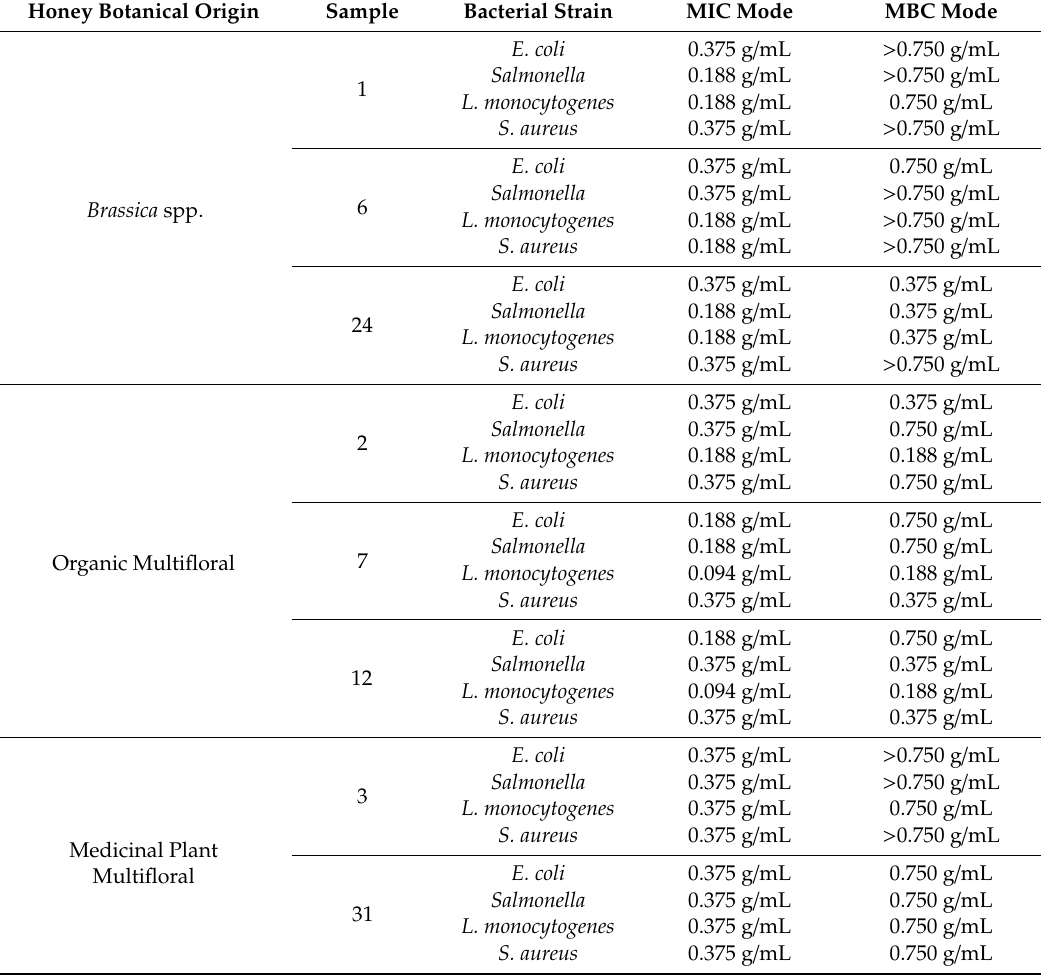
Table 2. Results of Minimum Inhibitory Concentration (MIC) and Minimum Bactericidal Concentration (MBC) tests of honey (modal